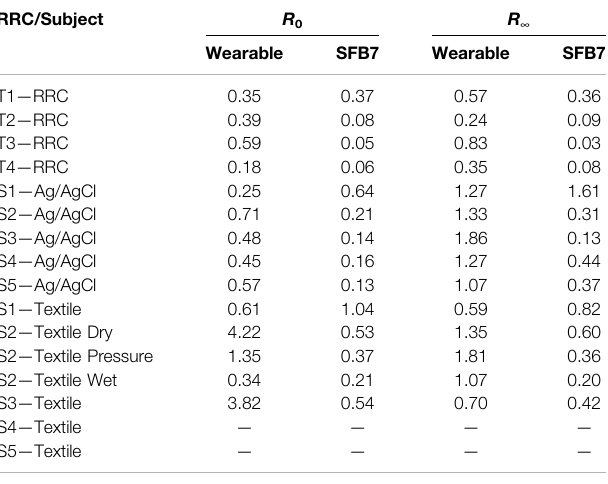
TABLE 5 | Cole parameter precision for the four different test RRC networks (T1 – 4) and the human subjects (S1 – S5) using Ag/AgCl and textile electrodes. All values in percent of the mean of that parameter (see Eq. 9 ). Fitting was not performedfortextilesforsubjectsS4/S5duetoartifactsinthemeasurements(see Section 3.2 ).